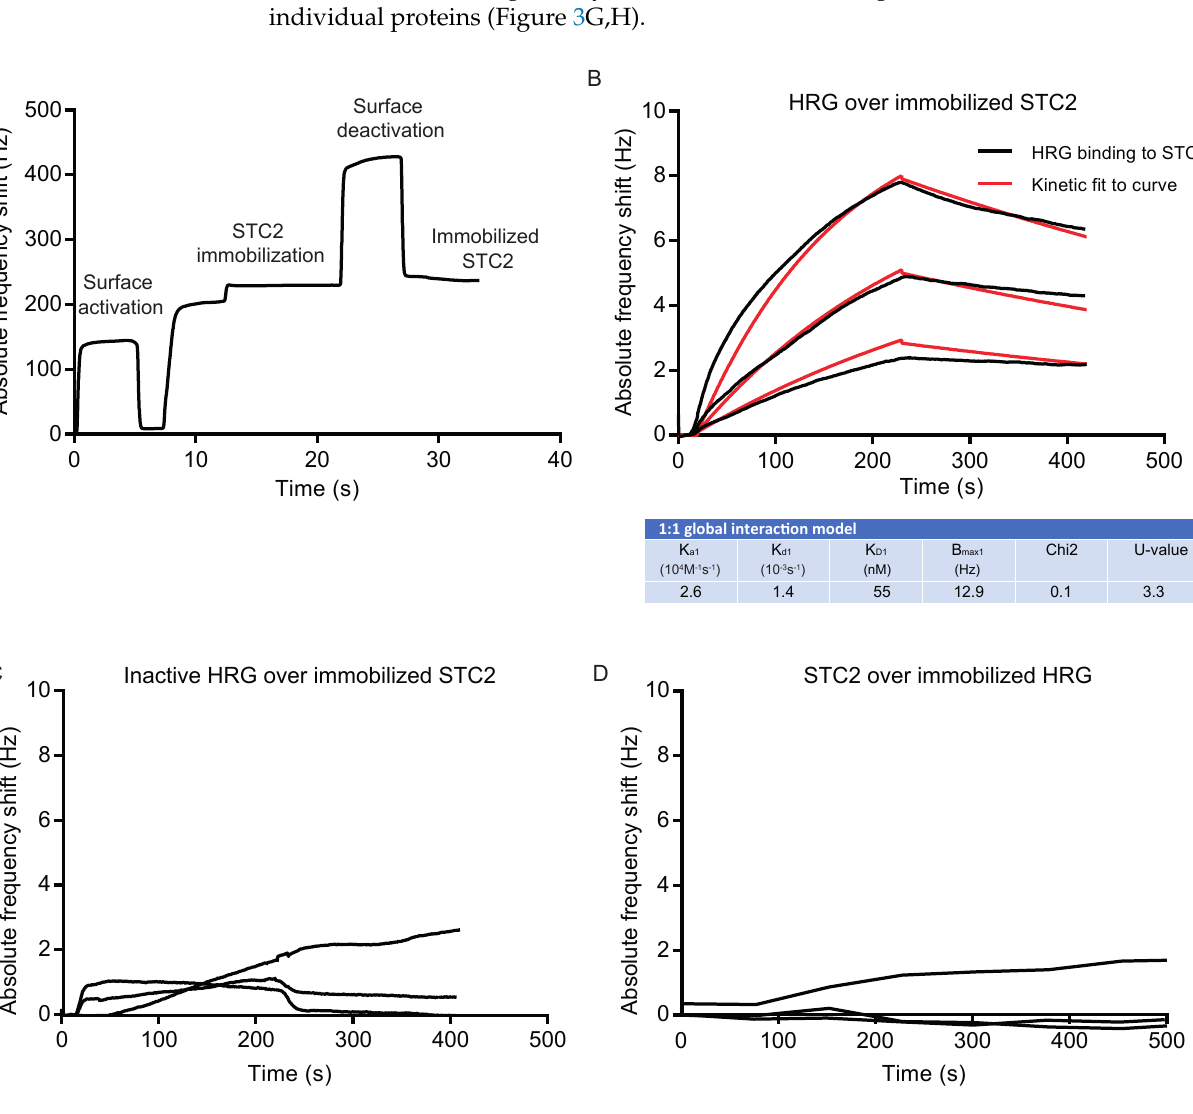
Figure 2. Affinity determination of HRG’s binding to STC2 using QCM. ( A ) The immobilization of STC2 on the QCM LNB sensor surface. ( B ) Sensorgram and kinetic analysis showing chip- immobilized STC2 and binding of HRG at three different concentrations: 50, 100 and 200 nM. Black lines: experimental curves. Red lines: fitted curves. For representative sensorgram shown, three injections per concentration, two independent experiments. ( C ) Sensorgram showing chip- immobilized STC2 and lack of binding of inactive HRG tested at three different concentrations: 50, 100 and 200 nM. For representative sensorgram shown, three injections per concentration, two independent experiments. ( D ) Sensorgram showing chip-immobilized HRG and lack of binding of STC2, tested at three different concentrations: 200 nM, 450 nM and 900 nM. For representative sensorgram shown, two injections per concentration, three independent